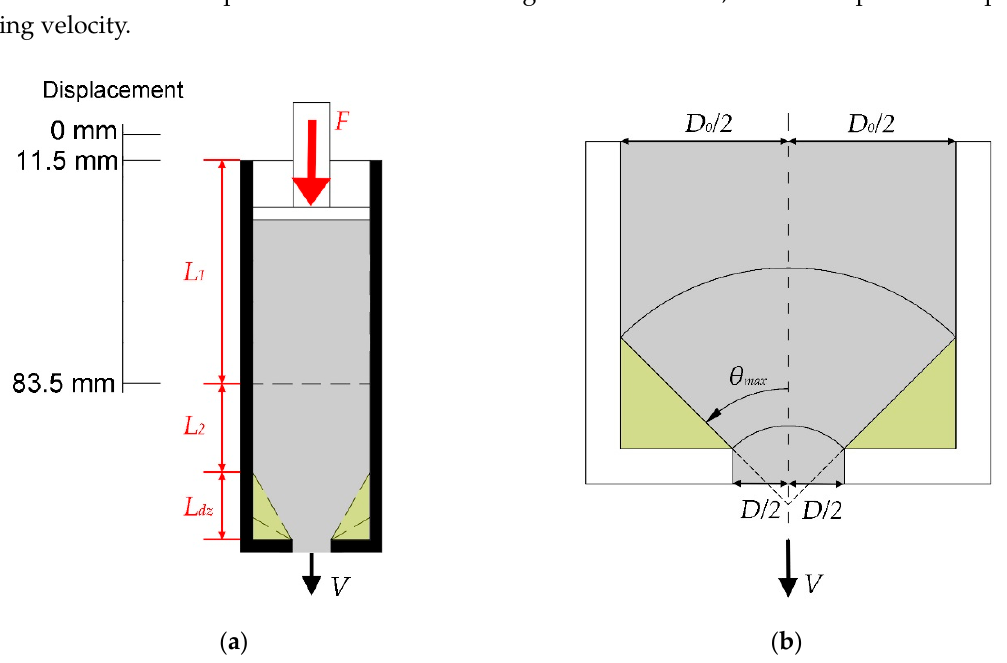
Figure 5. ( a ) Schematic diagram of the barrel section, L 1 is the maximum piston moving depth, L dz is the length of dead zone, L 2 is the distance between the piston moving area and the dead zone; ( b ) illustration of the die entrance flow region in a spherical coordinate system, based on Basterfield et al. [30] and Zhou et al. [26]. Yellow areas represent the static zone in the barrel during the extrusion test.